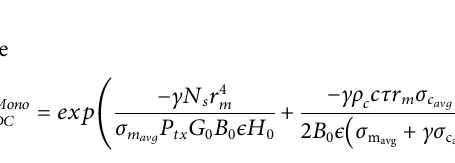
Frontiers in Signal Processing |